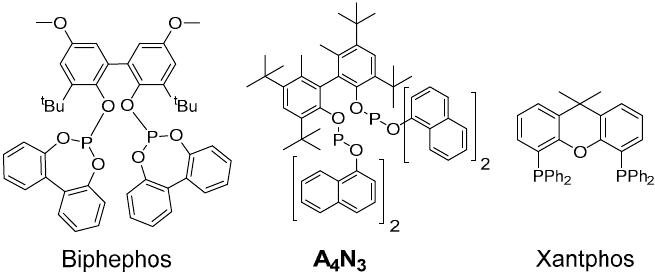
Figure 1. Ligands used in the tandem isomerization–hydroformylation of oleonitrile. Table 4. Comparison of Rh–Biphephos, Rh– A 4 N 3 , and Rh–Xantphos catalytic systems. 1